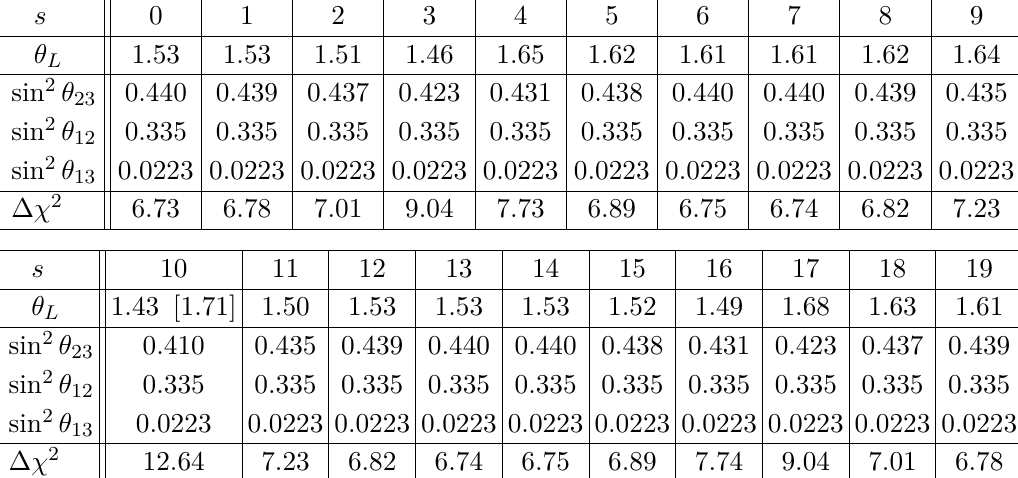
Table 9 . Case 3 b.1) Results for a larger value of n , n = 20 , together with m = 9 and 0 ≤ s ≤ n − 1 = 19 . The results for m = 11 can be deduced from the displayed ones, using the symmetry transformations given in [22]. For light neutrino masses with NO we give ∆ χ 2 resulting from the fit to the global fit data [41]. The presence of a second best fit value for θ brackets.